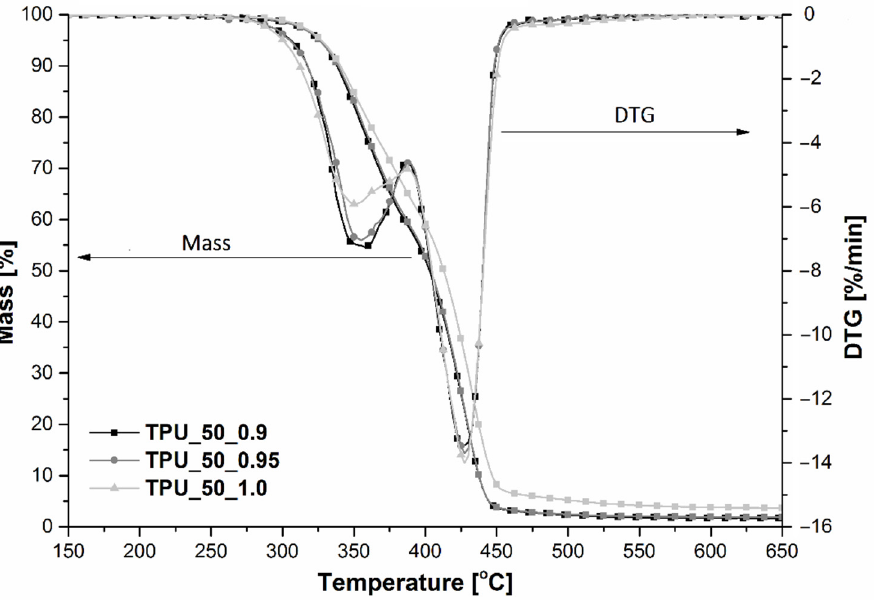
Figure 4. The dependence of mass/DTG and temperature for TPUs obtained in different [NCO]/[OH] molar ratios.